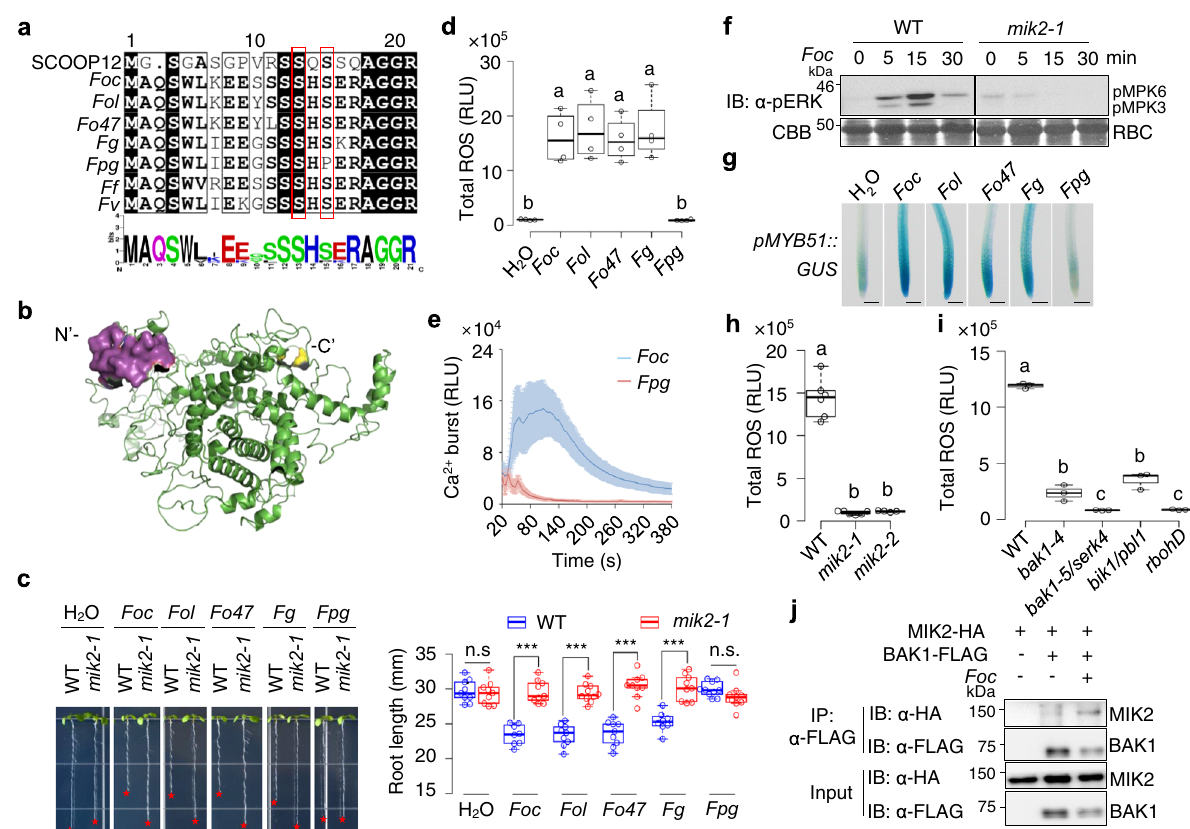
Fig. 6 Fusarium SCOOP-like peptides activate MIK2-dependent immune responses. a Alignment of SCOOPL SxS motifs from different Fusarium strains with Arabidopsis SCOOP12. Foc , F. oxysporum f. sp. conglutinans Fo 5176; Fol , F. oxysporum f. sp. lycopersici MN25; Fo 47, F. oxysporum 47; Fg , F. graminearum PH-1; Fpg , F. pseudograminearum ; Ff , F. fujikuroi ; Fv , F. venenatum . Two conserved serine (S) residues are boxed in red. b The surface accessibility of Fg SCOOPL. Fg SCOOPL peptide is highlighted in magenta, the C-terminus in yellow, and the rest in green. c Fusarium SCOOPL peptides, except Fpg SCOOPL, inhibit root growth in a MIK2-dependent manner. Images of 10-day-old WT and mik2-1 seedlings with or without 1 µ M Fusarium SCOOPL peptides. Scale bar, 4 mm (left). Quanti fi cation of seedling root length (right) (*** P < 0.001, n.s., no signi fi cant differences, two-tailed Student ’ s t -test, n = 9, 9, 8, 9, 9, 10, 9, 9, 8, 9, 10, 9 for plots from left to right). d Fusarium SCOOPLs, except Fpg SCOOPL, induce ROS production. WT seedlings were treated with or without 1 µ M peptides, and ROS was calculated as total RLUs. Different letters indicate a signi fi cant difference with others ( P < 0.05, one-way ANOVA followed by Tukey ’ s test, n = 4). e Foc SCOOPL triggers the cytosolic Ca 2 + increase. p35S::Aequorin seedlings were treated with or without 1 µ M Foc SCOOPL or Fpg SCOOPL. Cytosolic Ca 2 + concentration was indicated as means of RLU. The data are shown as mean ± SE ( n = 9 and 6 for Foc SCOOPL and Fpg SCOOPL). f Foc SCOOPL-induced MAPK activation is blocked in mik2-1 . Ten-day-old seedlings were treated with or without 1 µ M Foc SCOOPL. g Fusarium SCOOPLs induce pMYB51::GUS expression in roots. Images of root tips of 1-week-old pMYB51::GUS seedlings upon treatments with or without 1 µ M SCOOPLs for 3 h and subjected to GUS staining. Scale bar, 1 mm. h , i Foc SCOOPL-induced ROS production is blocked in mik2 ( h ), and in bak1-4 , bak1- 5/serk4 , bik1 / pbl1 , and rbohD mutants ( i ). One-week-old seedlings were treated with 1 µ M Foc SCOOPL, and ROS production was calculated as total RLUs. Different letters indicate a signi fi cant difference with others ( P < 0.05, one-way ANOVA followed by Tukey ’ s test, n = 6, 6, 4 for plots from left to right in ( h ), n = 3 in ( i )). j Foc SCOOPL induces MIK2-BAK1 association. The experiment was performed as in Fig. 5f. Box plots in c , d , h , and i show the fi rst and third quartiles as bounds of box, split by the medians (lines), with whiskers extending 1.5-fold interquartile range beyond the box, and minima and maxima as error bar. Experiments in ( c – j ) were repeated three times with similar